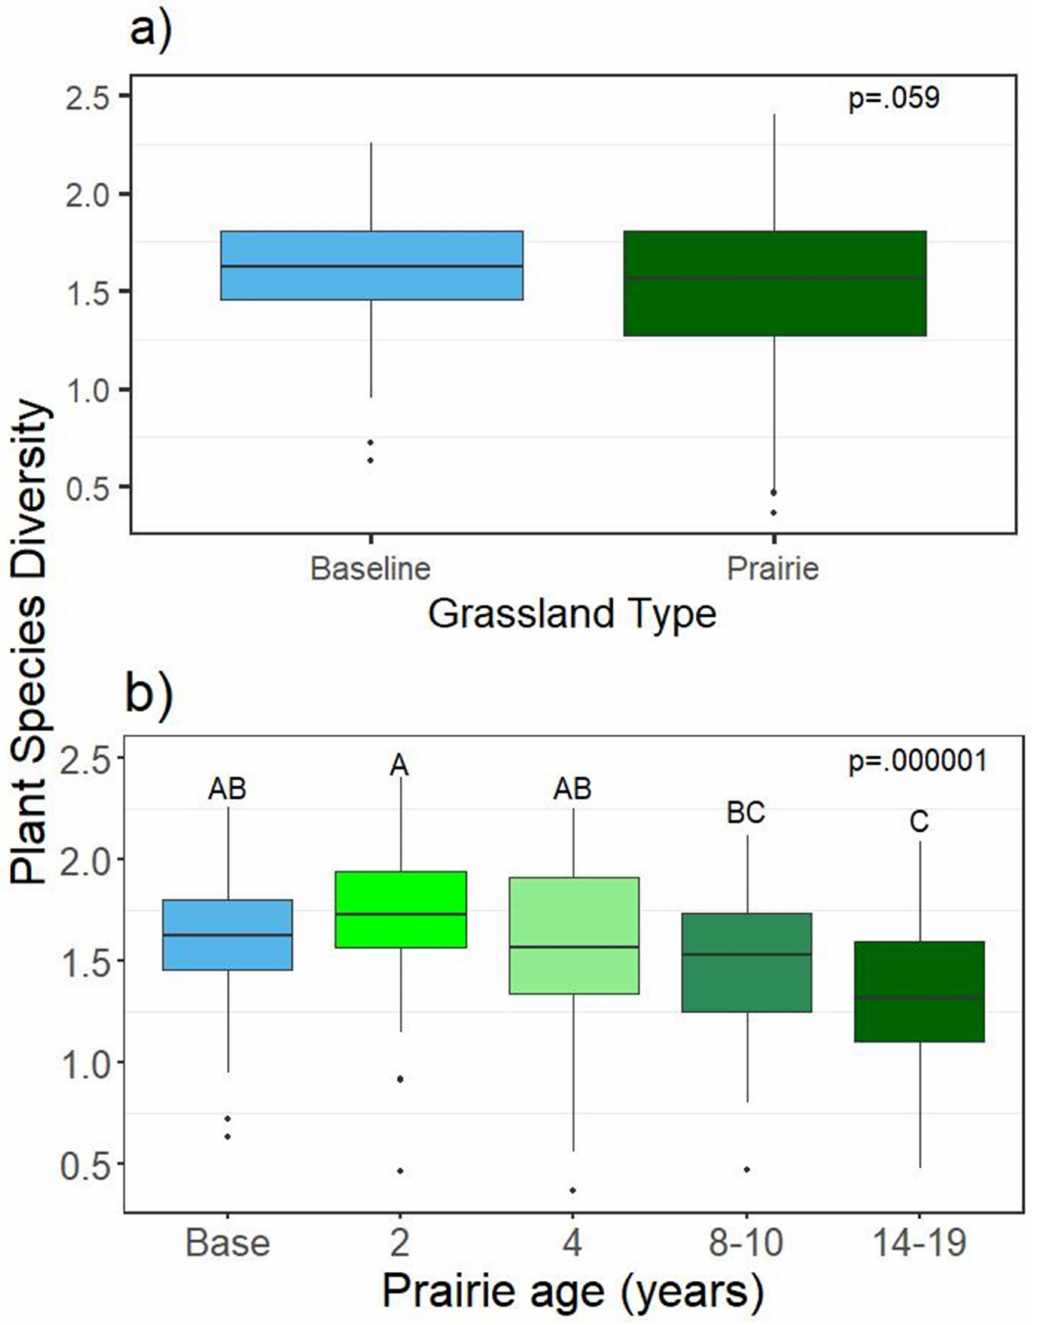
Figure 2. Average Shannon–Wiener plant species diversity in grasslands in 2018. ( a ) Grassland type, ( b ) prairie age. Baseline sites are cool season